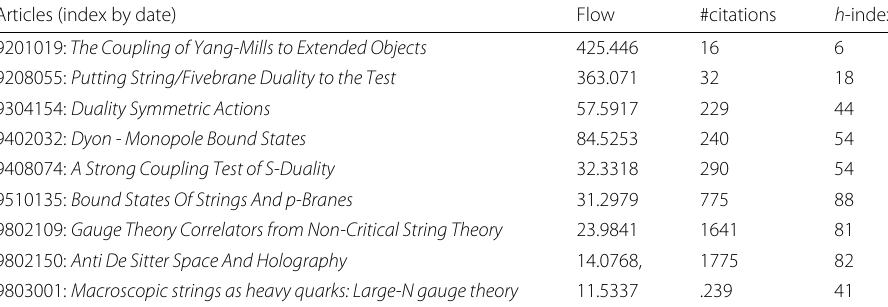
Table 2 The chain of max flow citations from ID9201019: The Coupling of Yang-Mills to Extended